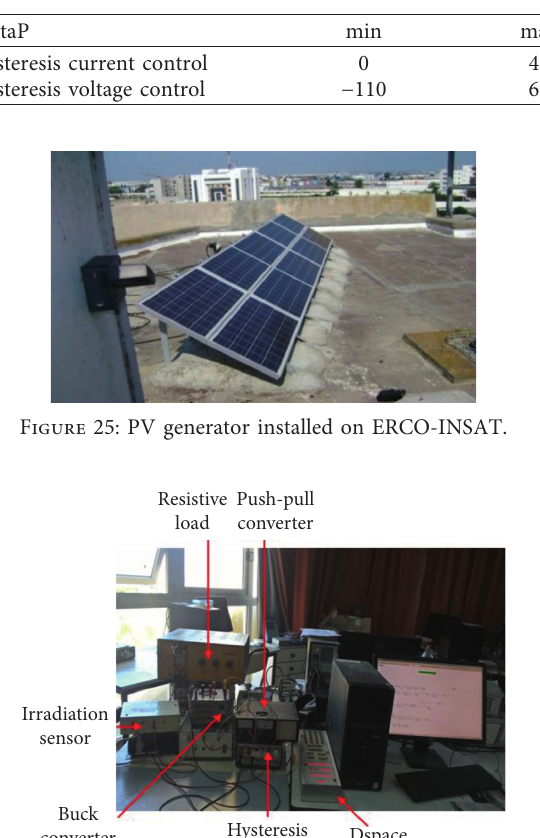
Figure 24: Evolution of “DeltaP” of voltage control. Table 2: Values of “DeltaP.”